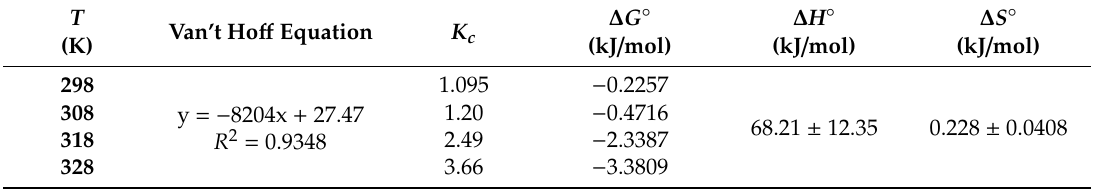
Table 3. Thermodynamic parameters for MB dye adsorption by CT- g -PAA / O-ECNFs